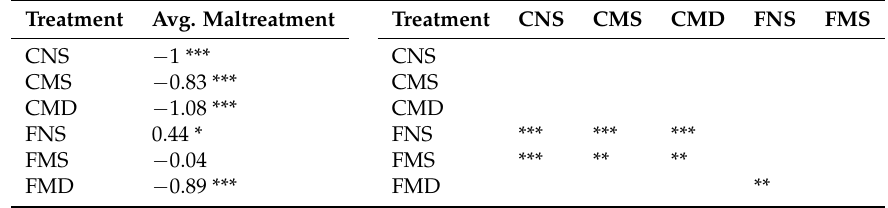
Table A8. Deviation from optimal treatment of Type M Patients across experimental